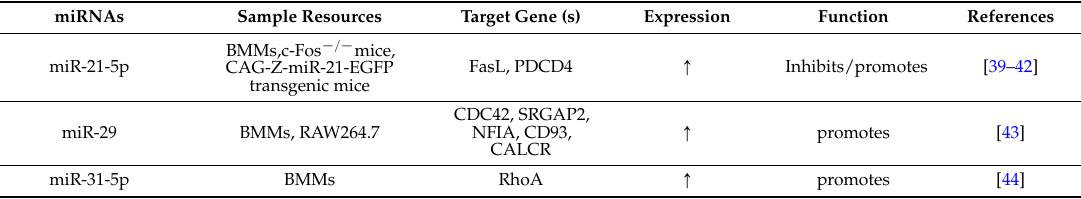
Table 1. Summary of miRNAs, their target genes, expression profile, and effects on osteoclasts.